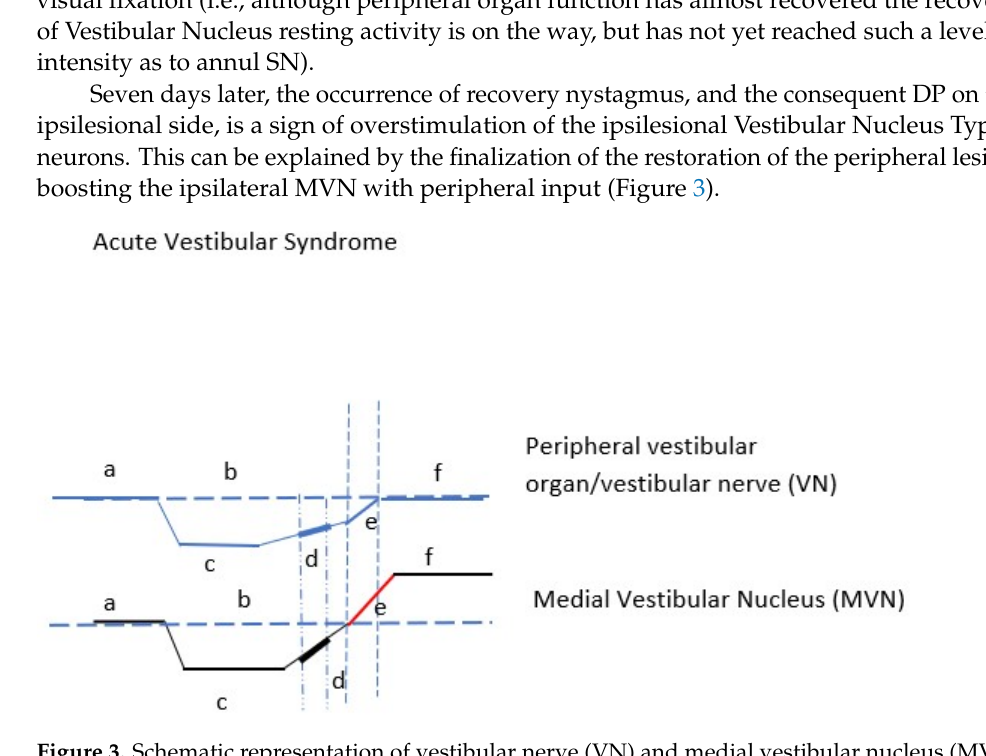
Figure 3. Schematic representation of vestibular nerve (VN) and medial vestibular nucleus (MVN) in acute vestibular syndrome. VN (a) peripheral organ normal function (b) activity line at rest, (c) peripheral organ deafferentation/hypofunction, (d) end organ begins to restore function, (e) final recovery of function, (f) peripheral organ function restored. MVN (a) nucleus baseline activity, (b) baseline activity line, (c) MVN discharge rate ceases, (d) beginning of resting discharge activity—beginning of central compensation, (e) the restoration of end organ function overstimulates the nucleus, (f) recovery nystagmus phase-nucleus hyperfunction. The thick sections in the restoration, (d) curves of VN and MVN represent the first consultation time point of the patient. Peripheral organ has regained much of its function, whereas the ipsilateral MVN begins to regain its intrinsic activity, not reaching yet the point of annulation of spontaneous nystagmus.